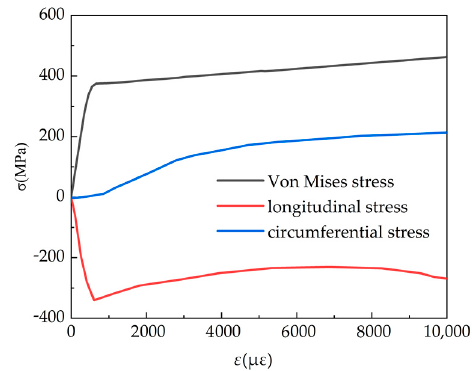
Figure 20. Curve of middle point of internal baffle.